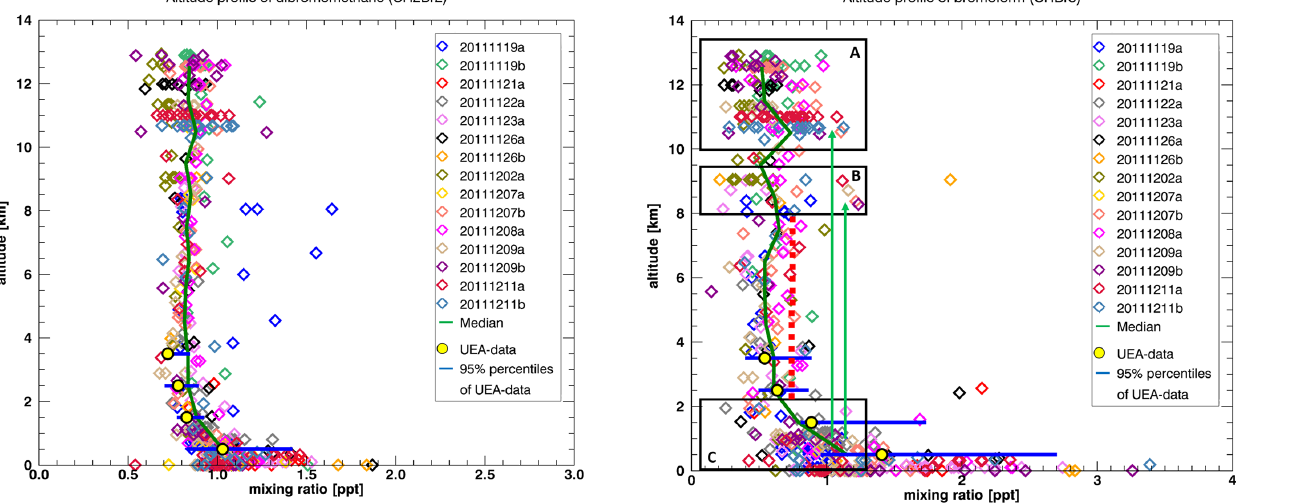
Figure 4. As Fig. 3, for CHBr 3 . Boxes A and B show regions in the upper troposphere (10–13km and 8–9.5km), where during some flights higher mixing ratios than in the free troposphere (2–8km) occur. The red dotted line shows the mean value of CHBr3 plus 1 σ atmospheric variability in the free troposphere (see also Table 4). The green arrows show possible transport pathways for air masses with higher mixing ratios from the planetary boundary layer (box C) into the upper regions of the atmosphere (boxes B and